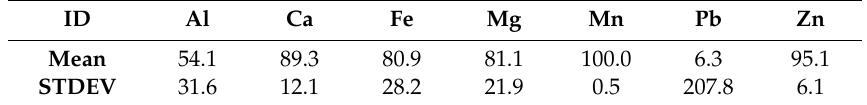
Table 4. Percentage reduction of PTEs from 50/50 stabilised moulds compared to raw Sinter ESP dust. Table 5. Percentage reduction of PTEs from 70 / 30 stabilised moulds compared to raw Sinter ESP